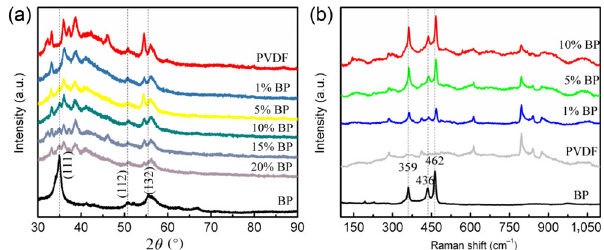
Fig. 31 (a) XRD patterns of BP, PVDF and BP/PVDF com- posites with different BP contents; (b) Raman spectra of BP, PVDF, and BP/PVDF composites with different BP